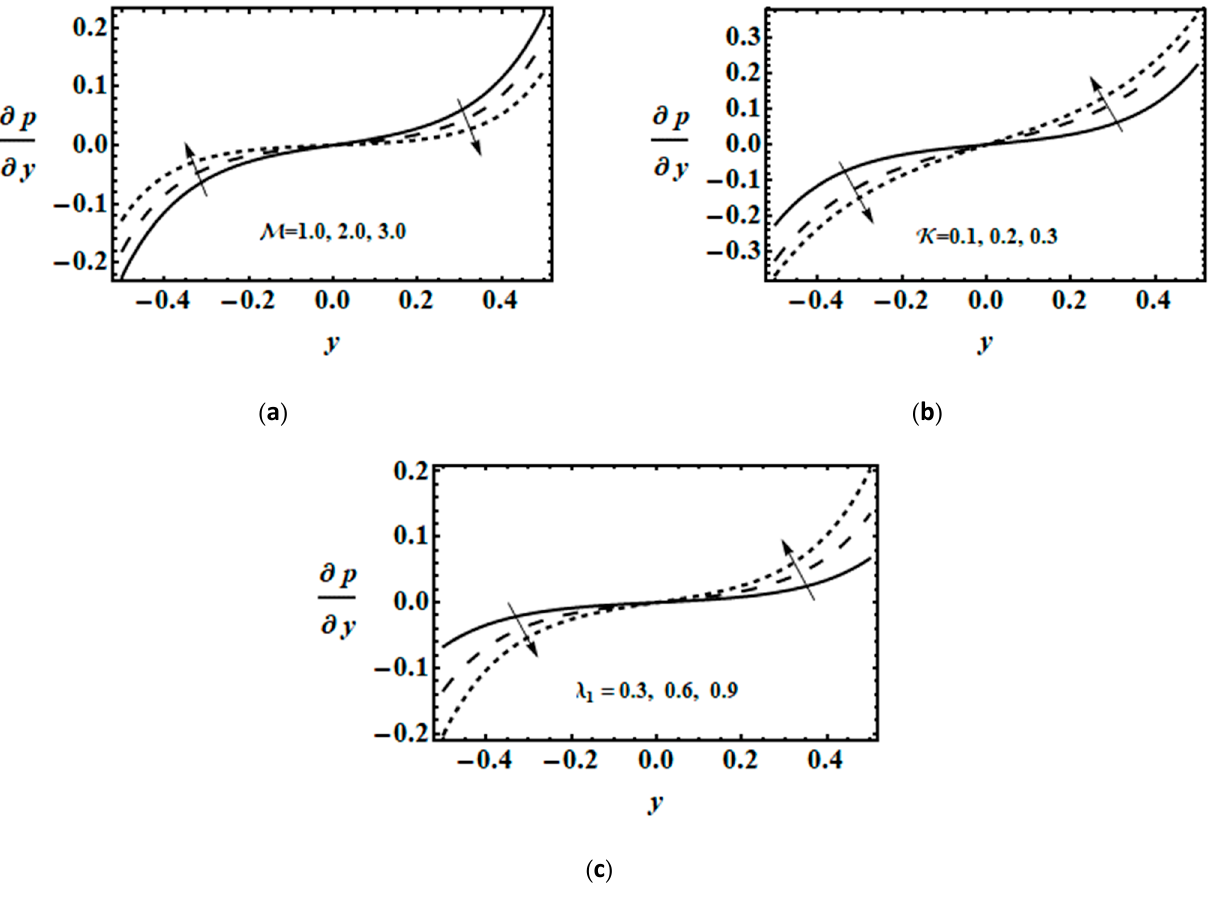
Figure 5. Influence of ( a ) M ( λ 1 = 1, K = 0.1), ( b ) K ( λ 1 = 1, M = 1 ) and ( c ) λ 1 ( M = 1, K = 0.1) on the vertical pressure gradient for α = 0.4, β = 0.4, ε = 0.1, Q = 1.5, Re = 0.1.